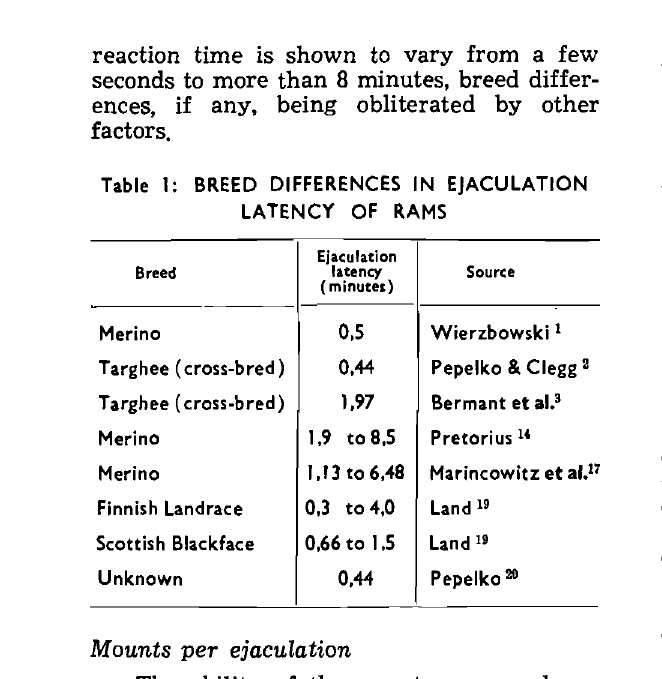
Table 2: NUMBER OF EJACULATIONS PER